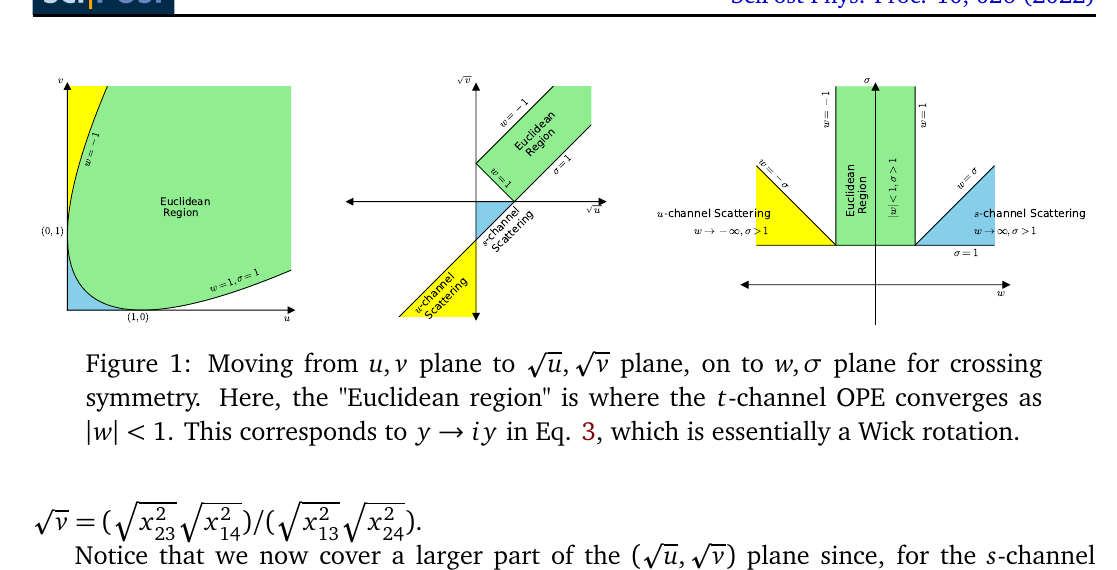
Figure 1: Moving from u , v plane to